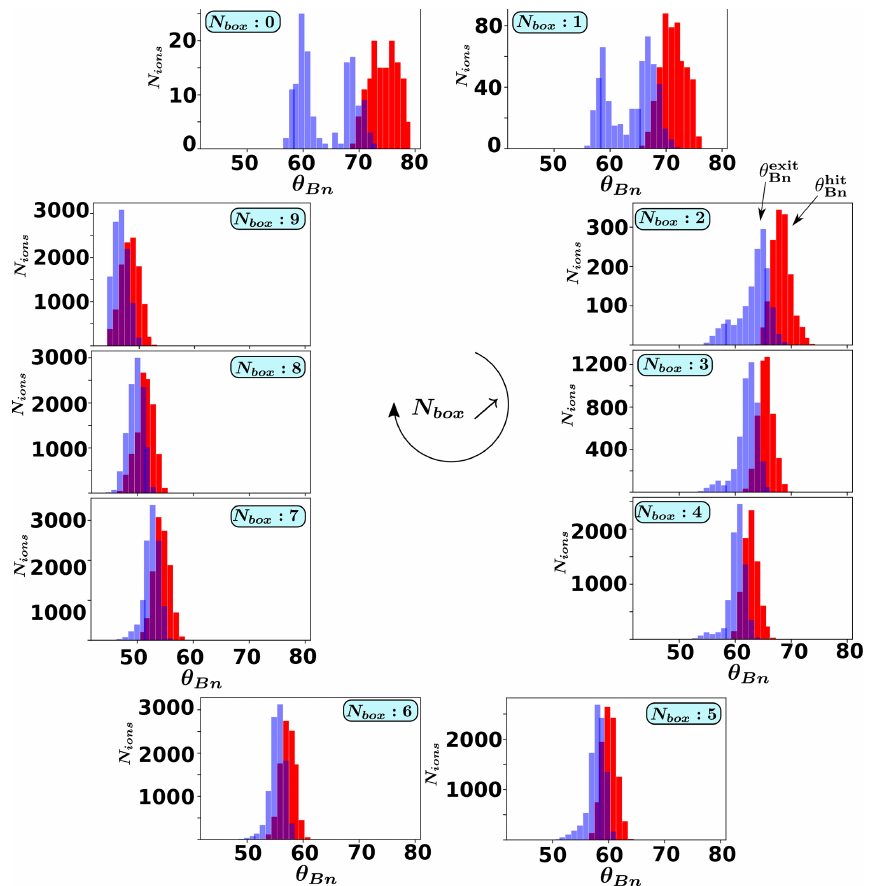
Figure 4. FCE configuration: plots of the ion distribution functions for each box N Box = 0–9 versus the local θ Bn angle computed when ions hit the shock front for the first time (red distribution function of the so-called θ hit distribution function versus the so-called θ exit N Box = 4–9. In fact, a close look at f 1 and f 2 shows that f